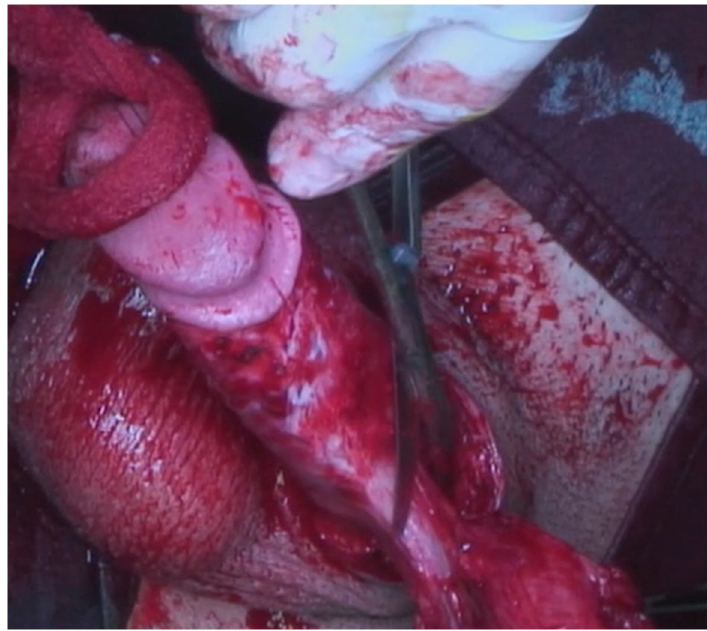
J. Clin. Med. 2023 , 12 , x FOR PEER REVIEW Figure 3. Excision of in fi ltrated tissues. Figure 3. Excision of infiltrated tissues.